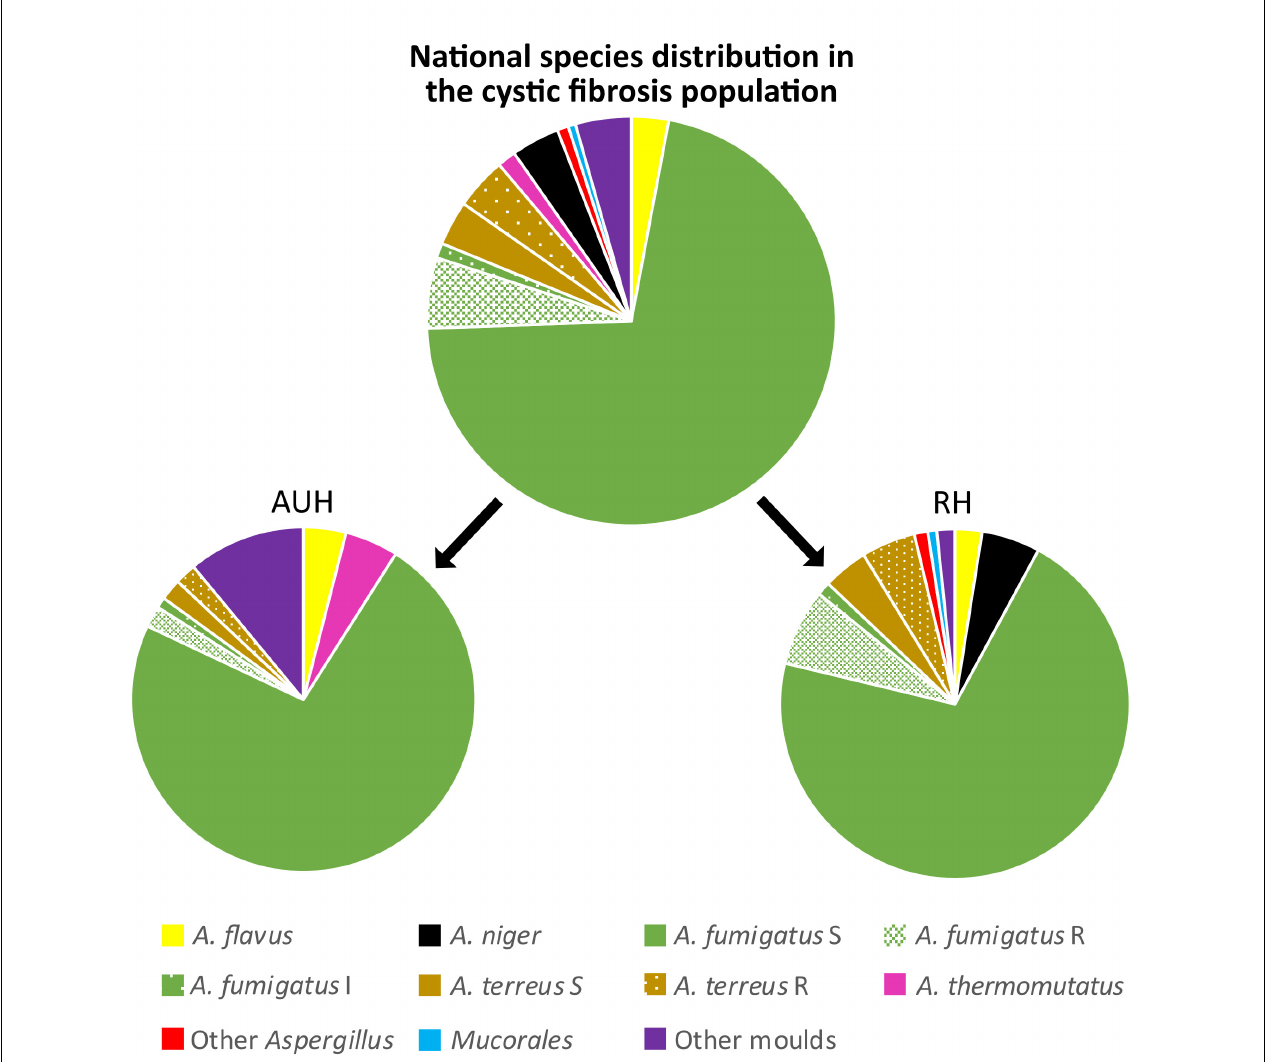
FIGURE 1 | Species distribution at the cystic fibrosis population gathered and at the two centers separately. S, I, and R indicate the susceptibility for azoles. S: susceptible, I: intermediate, and R: resistant. Aarhus (AUH): Other molds: Scedosporium spp. ( n = 8), Exophiala spp. ( n = 2), Penicillium spp. ( n = 1). Rigshospitalet (RH): Other Aspergillus : Aspergillus nidulans ( n = 2) and Aspergillus sydowii ( n = 1), Mucorales: Rhiomucor pusillus ( n = 1) and Zygomycetes spp. ( n = 1). Other molds: Scedosporium spp. ( n = 3), and Rasamsonia spp. ( n =